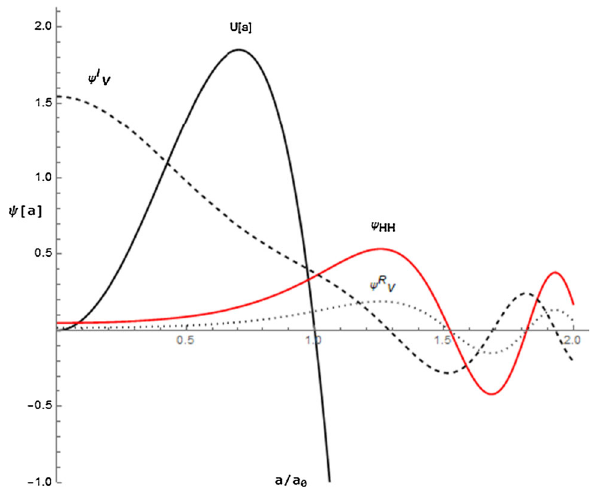
Fig. 2 The figure displays the solutions to the WDW equation when the factor ordering j = 1 is chosen and different boundary conditions are considered. This choice will not affect the semi-classical dynamics. In the figure we display the potential U (a)/3 (black curve), the wave functions for Hartle–Hawking (red curve) and for Vilenkin’s approach (dashedanddottedcurves).FortheVilenkin’sboundaryconditionsboth the real and the imaginary part are shown and indicated with R and I respectively. The Hartle Hawking’s one is real